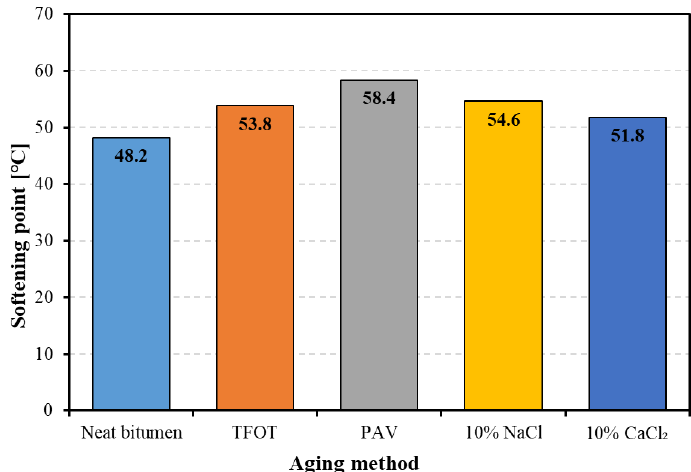
Figure 4. The softening point of bitumen before and after aging.